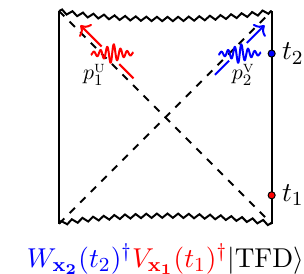
Figure 2 . Left : representation of the ‘in’ state V x the right boundary at time t 3 . Right : representation of the ‘out’ state W x a bulk slice that touches the right boundary at time t 2